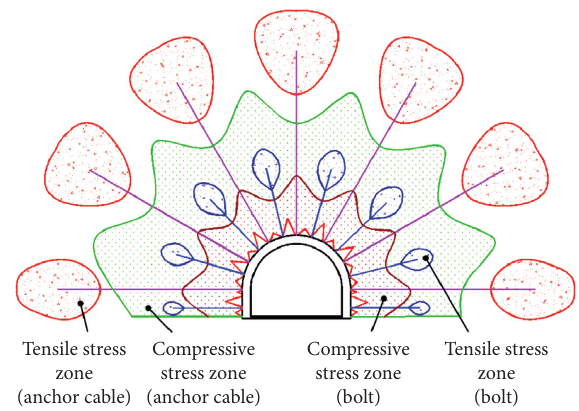
Figure 9: Combined support mechanism of bolt and anchor